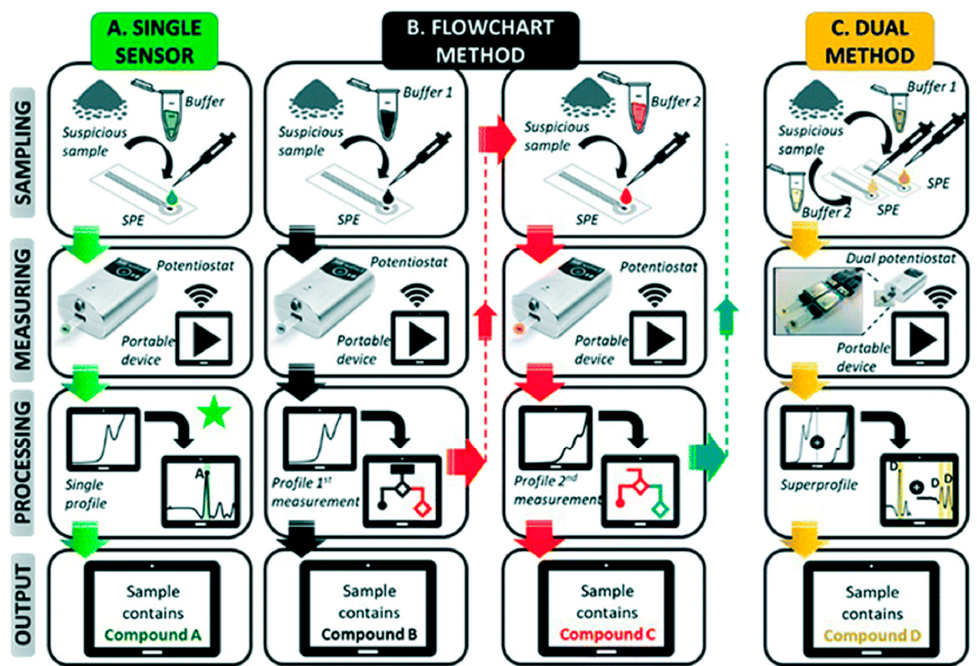
Figure 4. Schematic overview of three electrochemical methods for drug sensing [47]. Reused and adapted from the Royal Society of Chemistry under a Creative Commons Attribution- NonCommercial 3.0 Unported Licence.